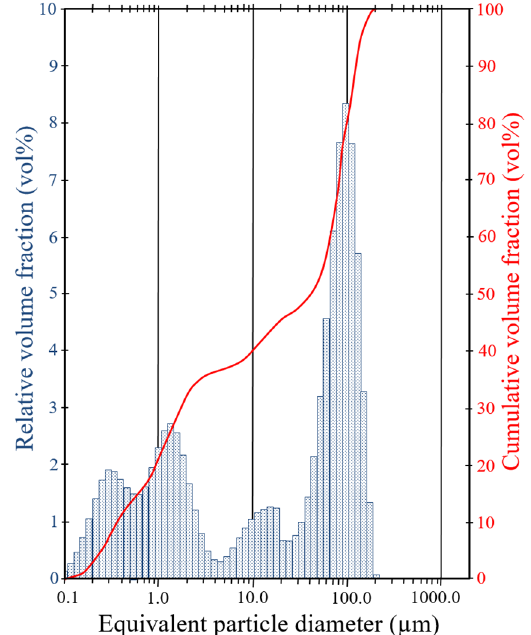
Figure 5. Particle size distribution in vol% of untreated Sra Ouertane (layer A1) phosphate rock.